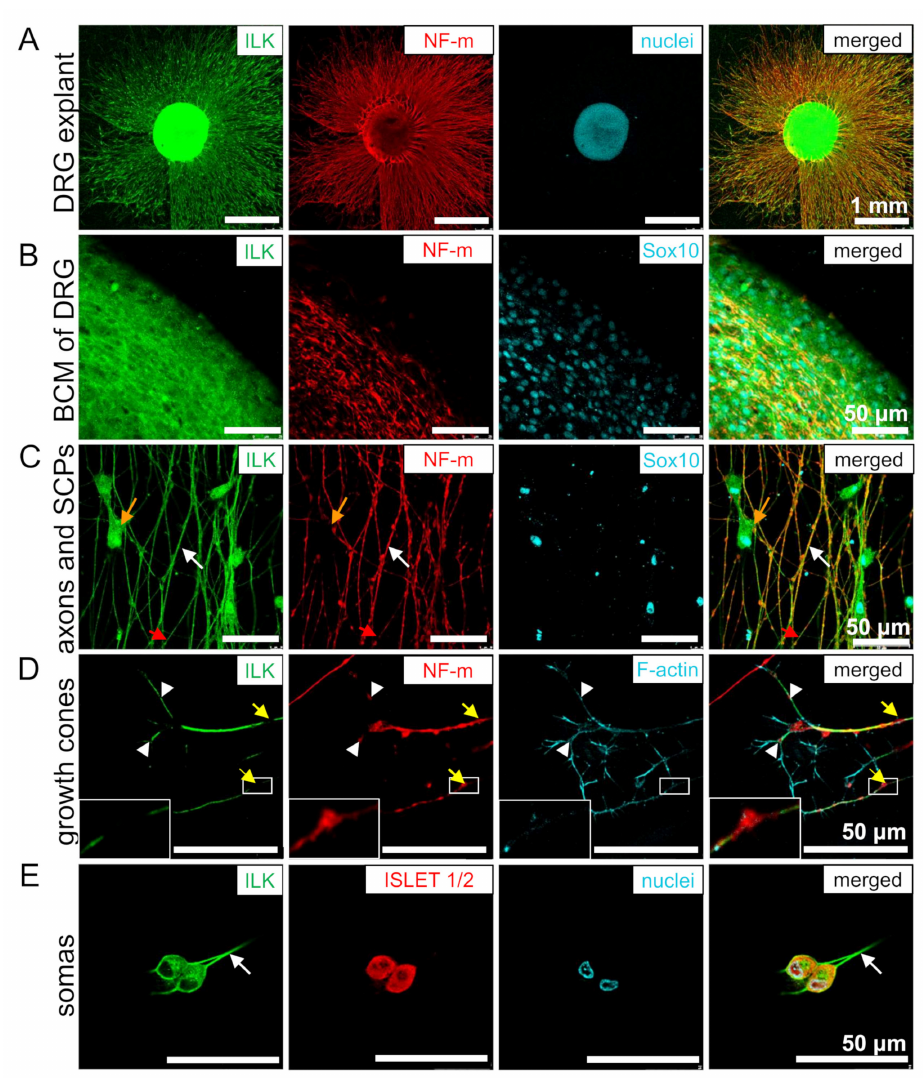
Figure 2. ILK is intracellularly localized in DRG neurons and SCPs. ( A – E ) Localization of integrin- linked kinase (ILK) in DRG explant and DRG single cells cultured on the surface coated with poly-D-lysine and additionally laminin-1. DRG explants and cells were cultured for 48 h and then immunostained in the permeabilized conditions with antibodies against ILK, NF-m, Sox10, and ISLET 1/2. To detect F-actin and cell nucleus, the specimens were stained with fluorescently labeled phalloidin and Hoechst 33342, respectively; ( A ) Images representing the whole DRG explant; ( B ) Images showing the presence of ILK in BCM of DRG; ( C ) Images representing ILK’s localization in axon shafts and SCPs. Orange arrows point to the presence of ILK in SCPs, white arrows indicate the localization of ILK in neurites, and the red arrows highlight neurofilament gaps in neurites; ( D ) Images showing ILK’s presence in growth cones and neurites. Yellow arrows point to the gaps in ILK-staining at the sites of neurofilaments accumulations. Enlarged images of these gaps are shown in the insets. White arrowheads highlight the filopodia of growth cones rich in NF-m; ( E ) The images of neuronal cell bodies were obtained from DRG single-cell cultures. White arrows point to